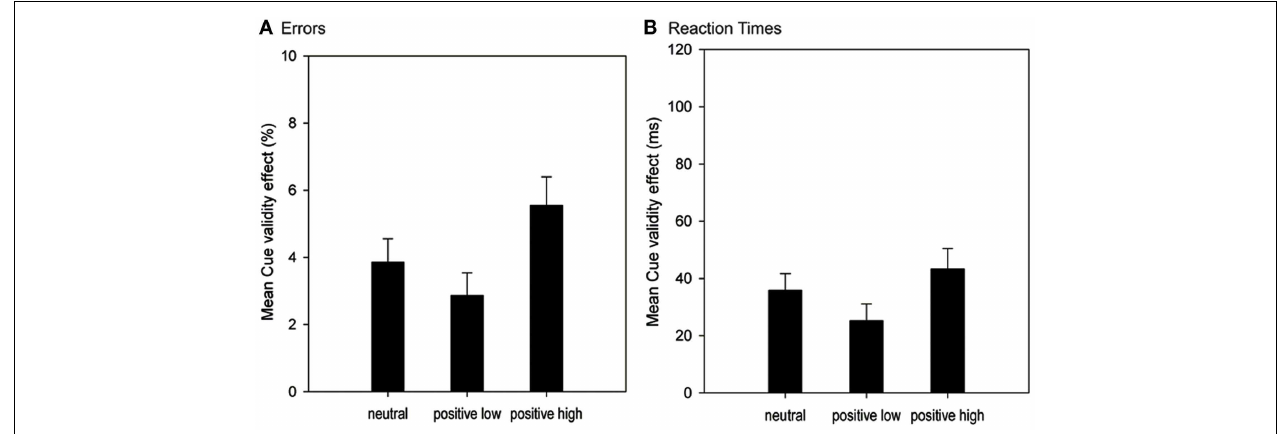
differences in error rates (in %), the (B) represents CVE differences in RTs (in ms). Error bars represent 1 standard error of the